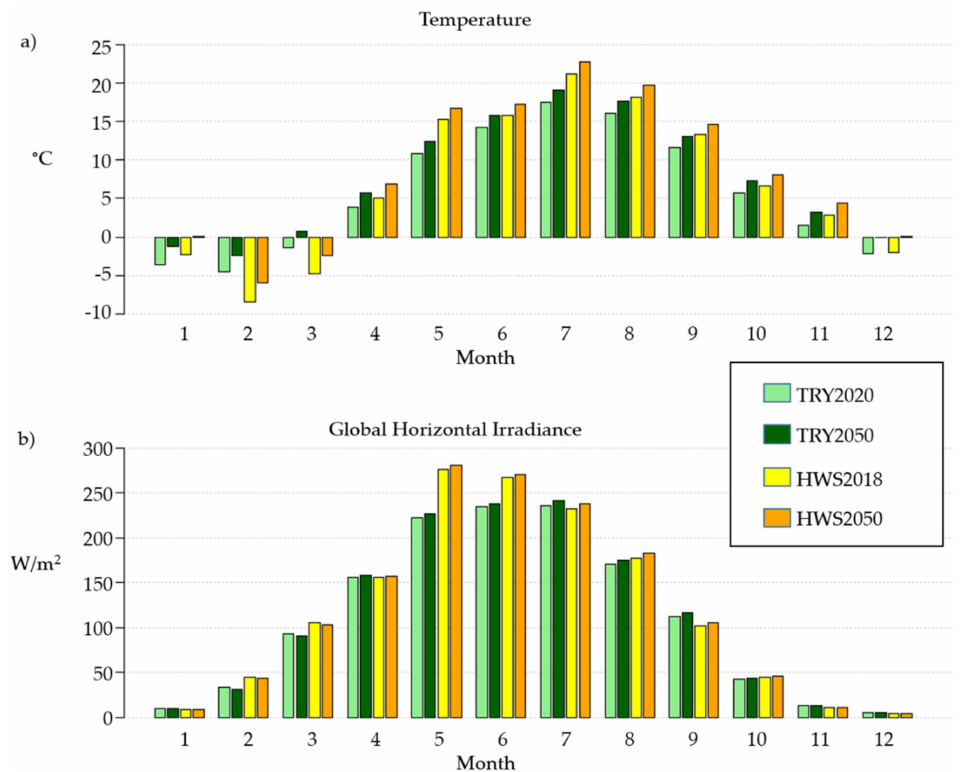
Figure 4. Monthly mean ( a ) temperature and ( b ) global horizontal irradiance at Helsinki-Vantaa in the test reference year (TRY2020), in test reference year projected for the year 2050 under the RCP4.5 scenario (TRY2050), during the year 2018 (HWS 2018), and year 2018 transformed to represent climate conditions around the year 2050